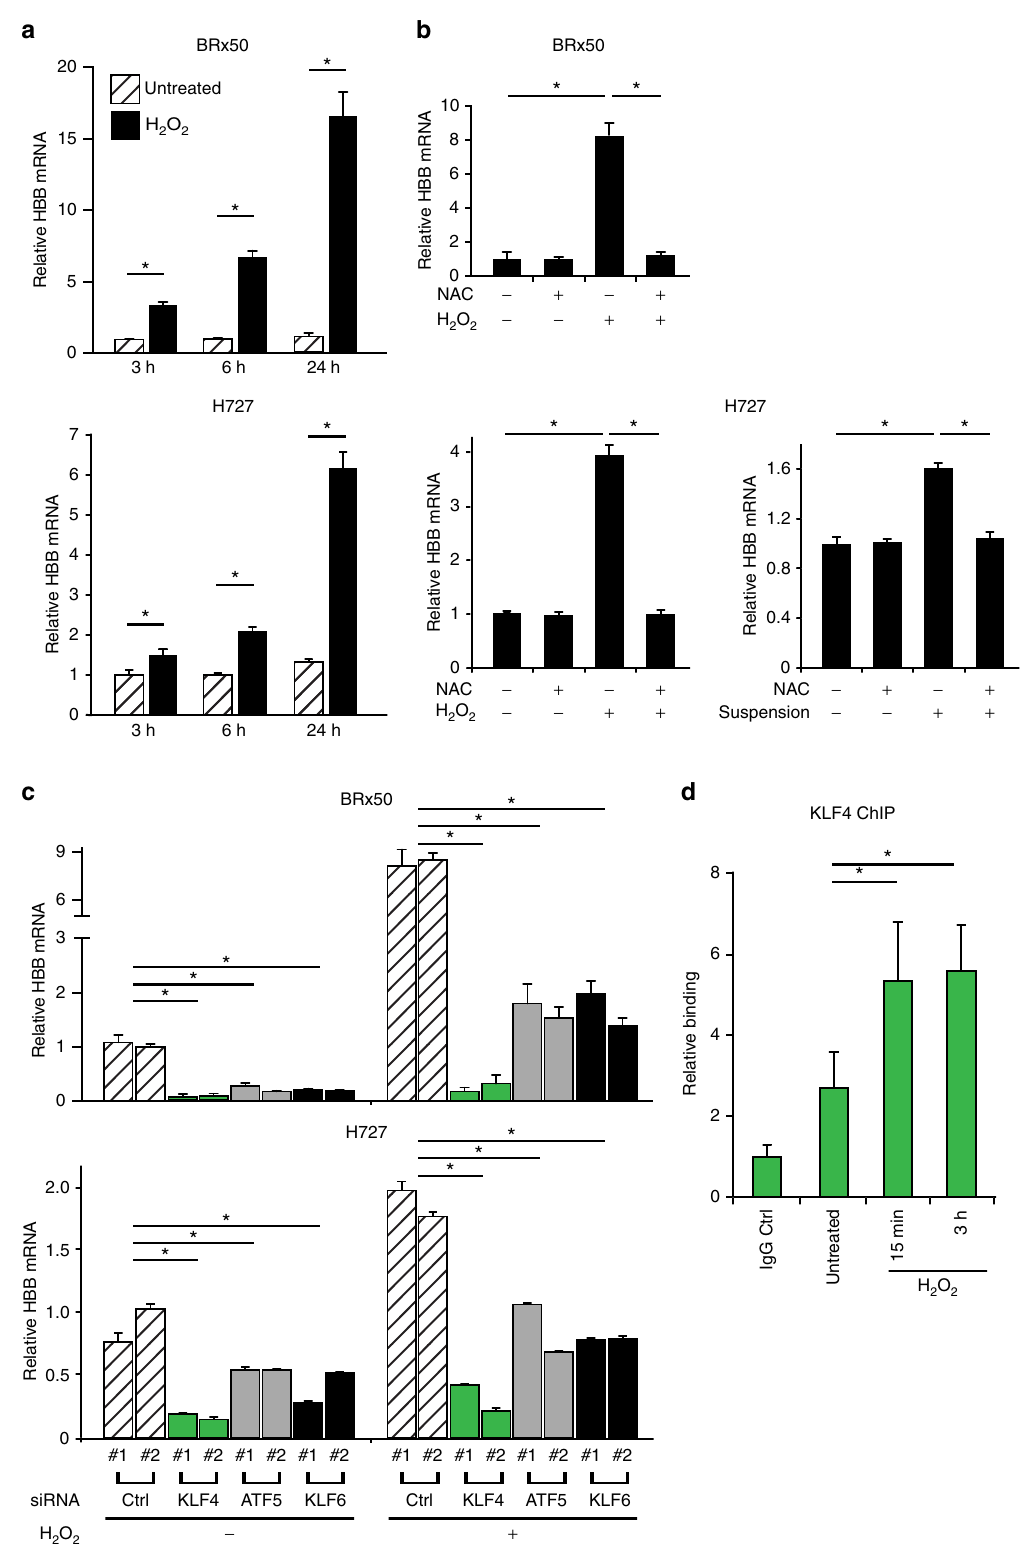
Figure 2 | HBB induction is mediated through KLF4 in response to increased intracellular ROS. ( a ) Bar graph showing time-dependent induction of HBB mRNA levels in H 2 O 2 treated BRx50 and H727 cells. ( b ) Bar graphs showing suppression of H 2 O 2 -induced HBB expression by the anti-oxidant N-acetyl cysteine (1mM NAC) in BRx50 and H727 cells, and suppression of suspension-induced HBB expression by NAC in H727 cells. ( c ) Bar graph showing that KLF4 depletion significantly decreases HBB expression under both basal and stimulated conditions in BRx50 and H727 cells. Knockdown of ATF5 or KLF6 has a modest effect. ( d ) ChIP assay showing direct binding of KLF4 to the promoter of HBB under basal conditions, with increased binding following exposure to H 2 O 2 in H727 cells. All data are represented as mean ± s.d. n ¼ 3; *denotes a statistical significance at P o 0.05 ( t